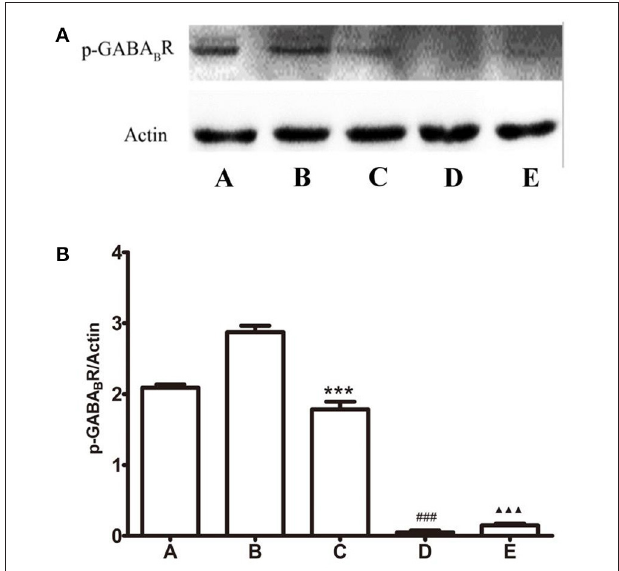
FIGURE 6 | Effects of FN stimulation, GABA B receptor agonist or antagonist microinjected into LHA on GABA B R-mRNA expression. (A) PCR analysis of expression of GABA B receptor. (B) Quantitative analysis of GABA B receptor expression in the LHA. β -action was used as a loading control. *** P < 0.001, as compared with the GI-R group; ### P < 0.001, as compared with the GI-R group; NNN P < 0.001, as compared with the GI-R group. A, Normal group; B, GI-R group; C, FN + GI-R + L -Glu group; D, LHA + GI-R + Baclofen group; E, LHA + GI-R + CGP35348 group. n = 5.